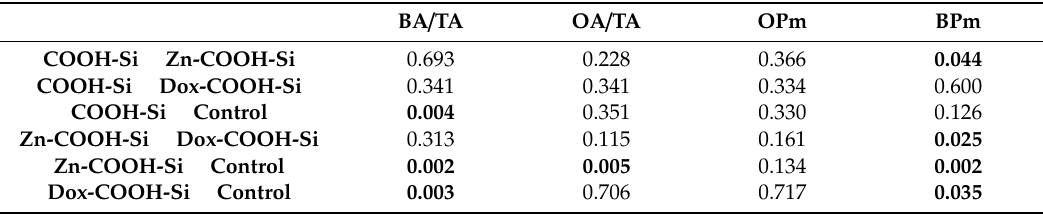
Table 4. Statistical results ( p values) after pairwise comparisons. Bold numbers mean significance at p < 0.05.